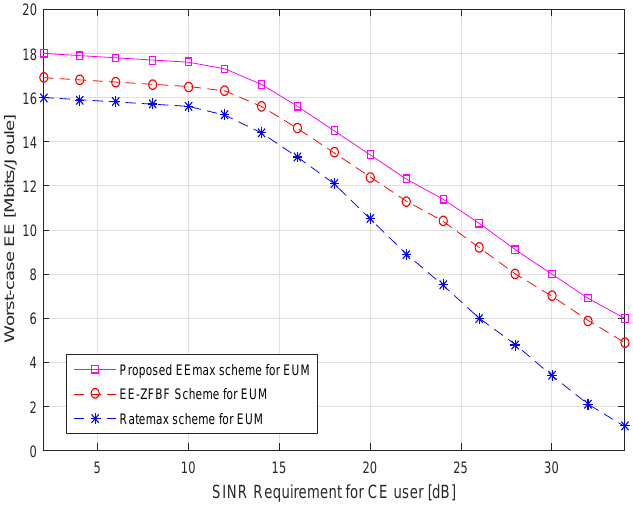
Figure 5. Worst-case EE versus signal-to-interference-plus-noise-power-ratio (SINR) requirement for cell edge (CE) users.